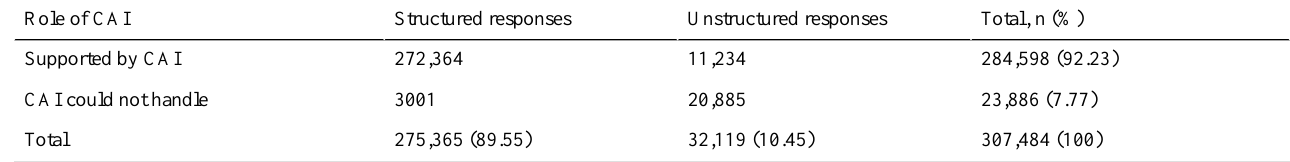
Table 6. Counts of the type of responses that were handled by the conversational artificial intelligence (CAI).